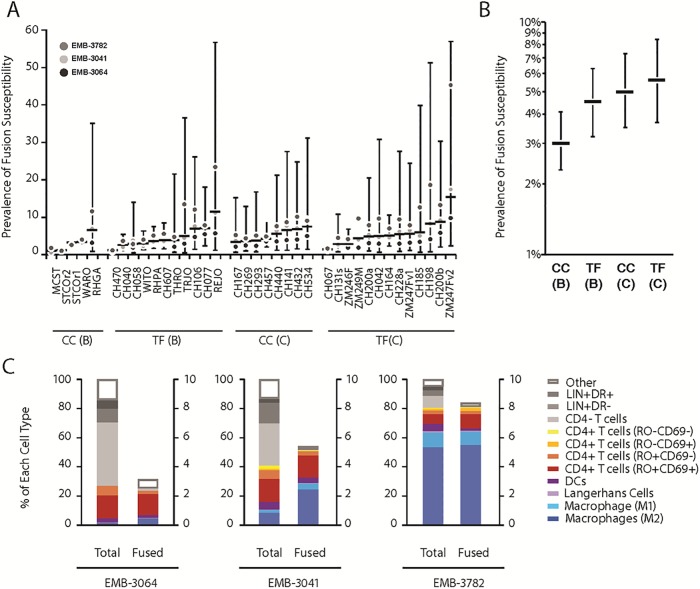
Fusion of 37 primary HIV-1 viruses to single cell suspensions from endometrial biopsies from 3 participants.Thirty-seven viruses containing BlaM-Vpr were obtained by co-transfection of 293T cells with infectious molecular clones and pcDNA4-3-BlaM-Vpr. Viral supernatants were concentrated and 500 ng p24Gag was used to infect single cell suspensions generated from EMBs from three participants not using a contraceptive (EMB-3064, EMB-3041 and EMB-3782). The fusion assay was combined with immunostaining and gating as performed in Fig 1. (A) For each of 37 viruses, we display the sampling distribution of the prevalence of immune cells supporting fusion (i.e. % Live CD45+BlaM+ cells) based on n = 3 participants. Here, the horizontal bar represents the mean while the vertical bar indicates the 95% confidence interval (CI) based on Student’s t-distribution (2 df). (B) Mean (95% CI) fusion susceptibility of 37 viruses grouped by HIV-1 status at the time of viral isolation (founder [TF] vs. chronic [CC]) and subtype (B vs. C). (C) For each participant, distribution of immune cells and fusion susceptibility prevalence by phenotype, averaged over 37 viruses.